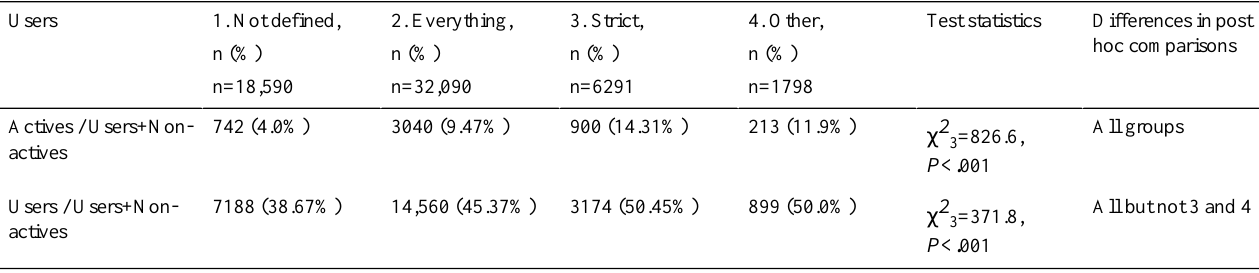
Table 5. Proportions of Semi-active and Active users in each dietary preference category out of all users who took at least one valid picture.